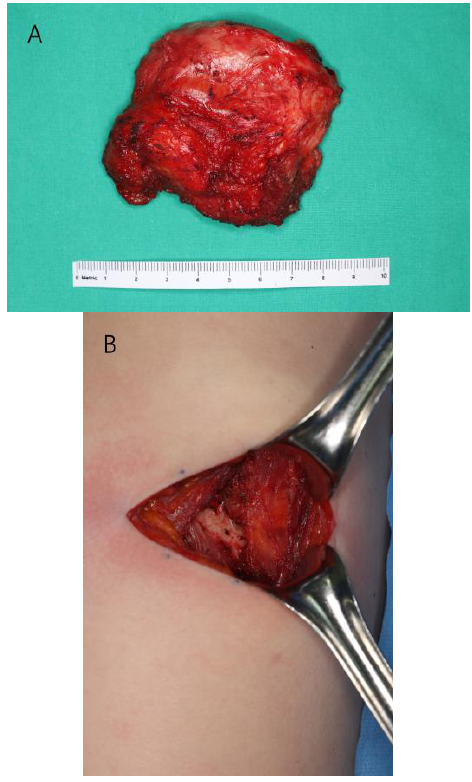
Figure 3. Intraoperative photographs during the first excision. ( A ) Excised mass. ( B ) Scapulothoracic joint space after mass excision.